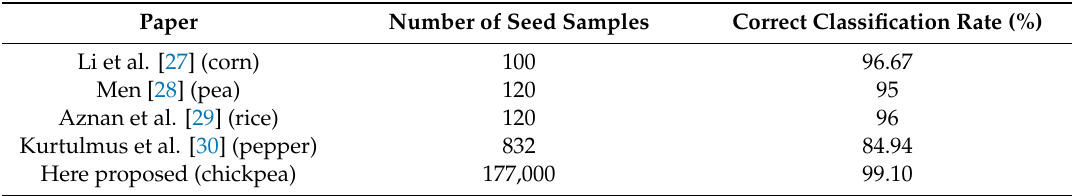
Table 11. Accuracy of the classifiers reported in di ff erent food seeds. Please note no direct comparison possible given the various works do not share the same image database and are for di ff erent food